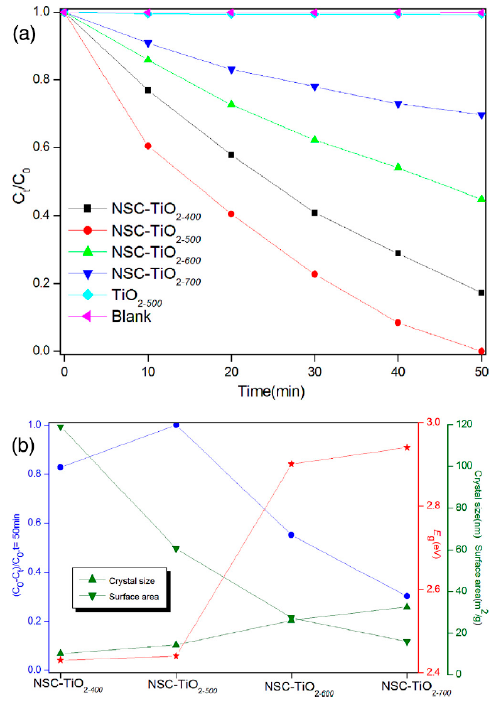
Figure 8. ( a ) Variation of Cr(VI) concentration (pH 1.5 and C0 = 10 mg/L) with irradiation time in the presence of TiO 2–500 and (N, S, and C) co-doped TiO 2-x samples under visible light ( λ > 420 nm) irradiation, together with the results from the blank experiments (no photocatalyst, but with visible light irradiation); ( b ) plots of [( C 0 − C t )/C 0 , t = 50 min] in comparison with Eg values, specific surface area, and crystal size for all (N, S, and C) co-doped-TiO 2-x samples. From Ref. [75]. Reprinted with permission from Elsevier.